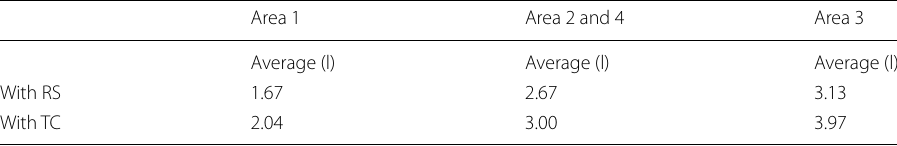
Table 10 Average performance for the Monarch image in terms of number of transmitted